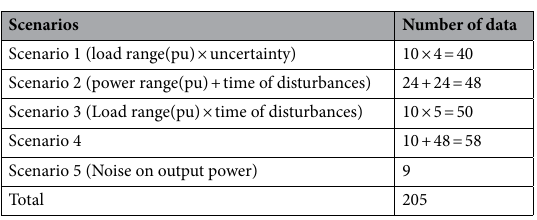
Table 2. Total data generated.